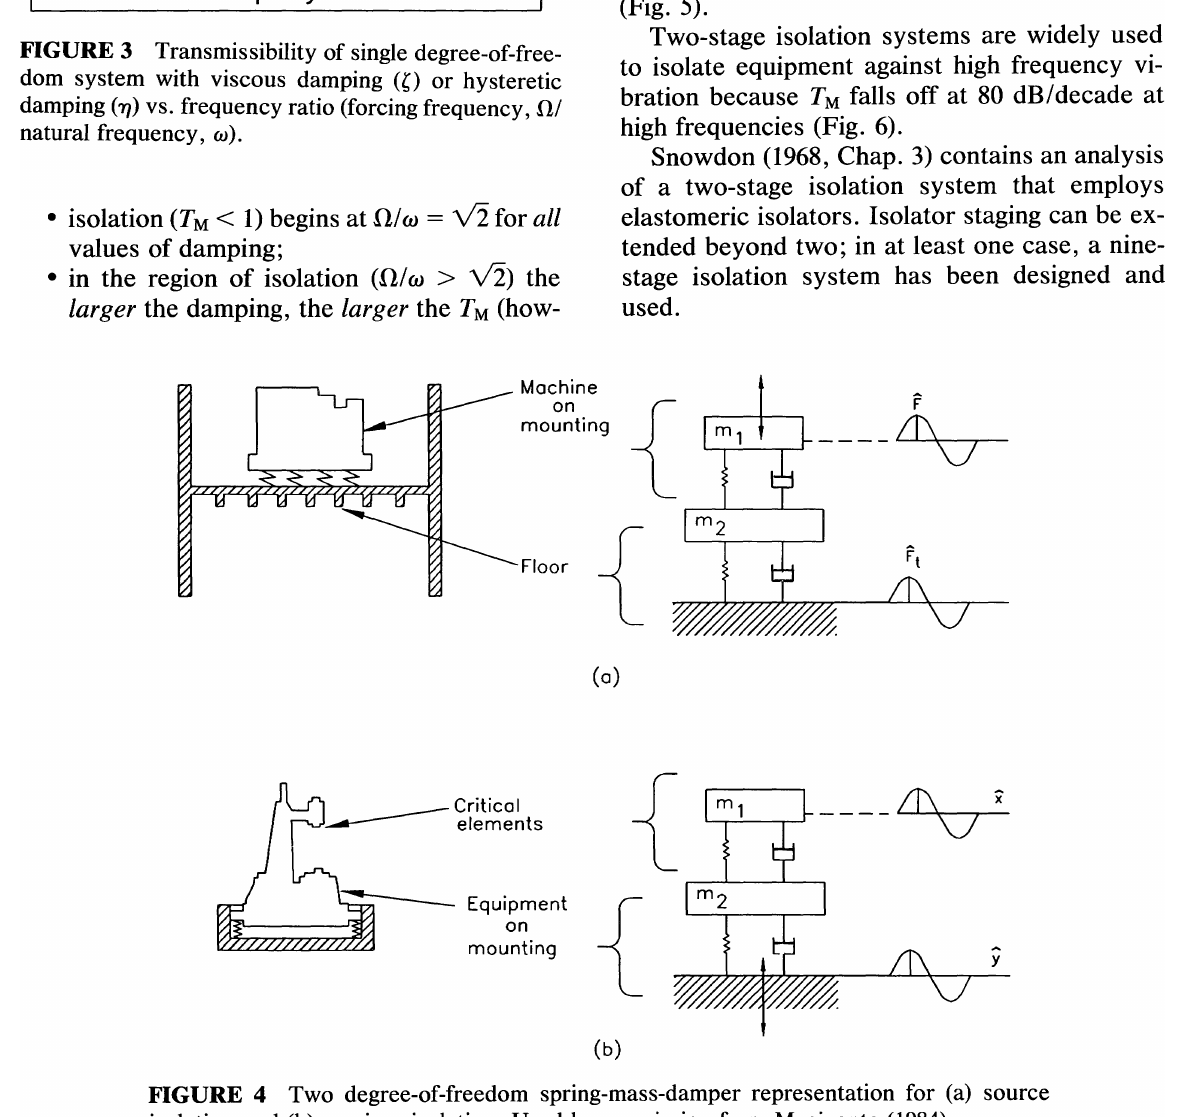
FIGURE 4 Two degree-of-freedom spring-mass-damper representation for (a) source isolation and (b) receiver isolation. Used by permission from Macinante